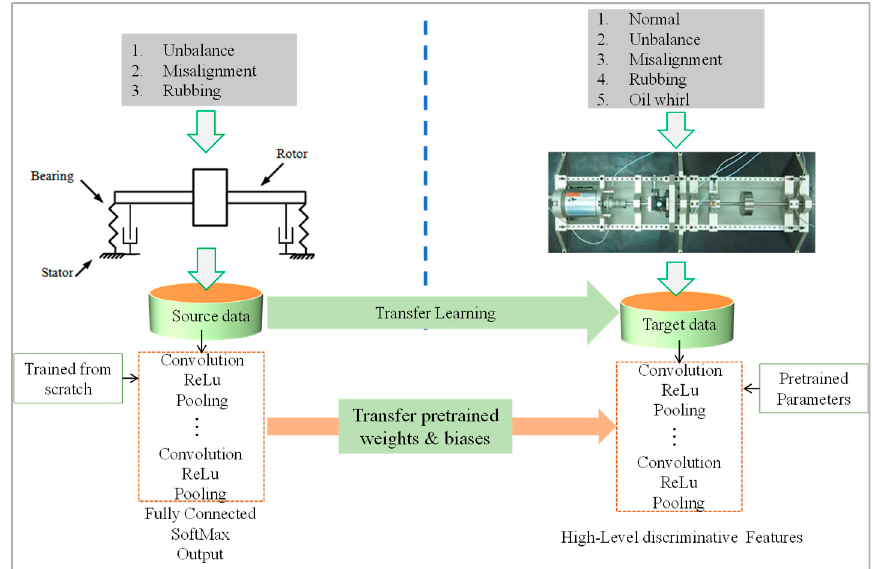
Figure 1. Fundamental idea of transfer learning.